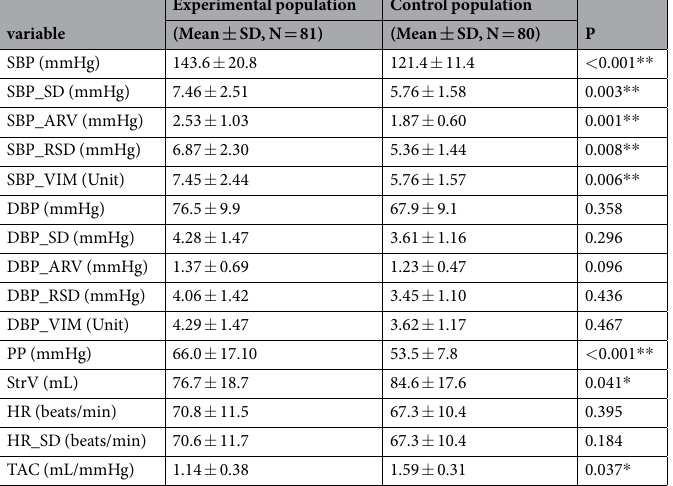
Control population